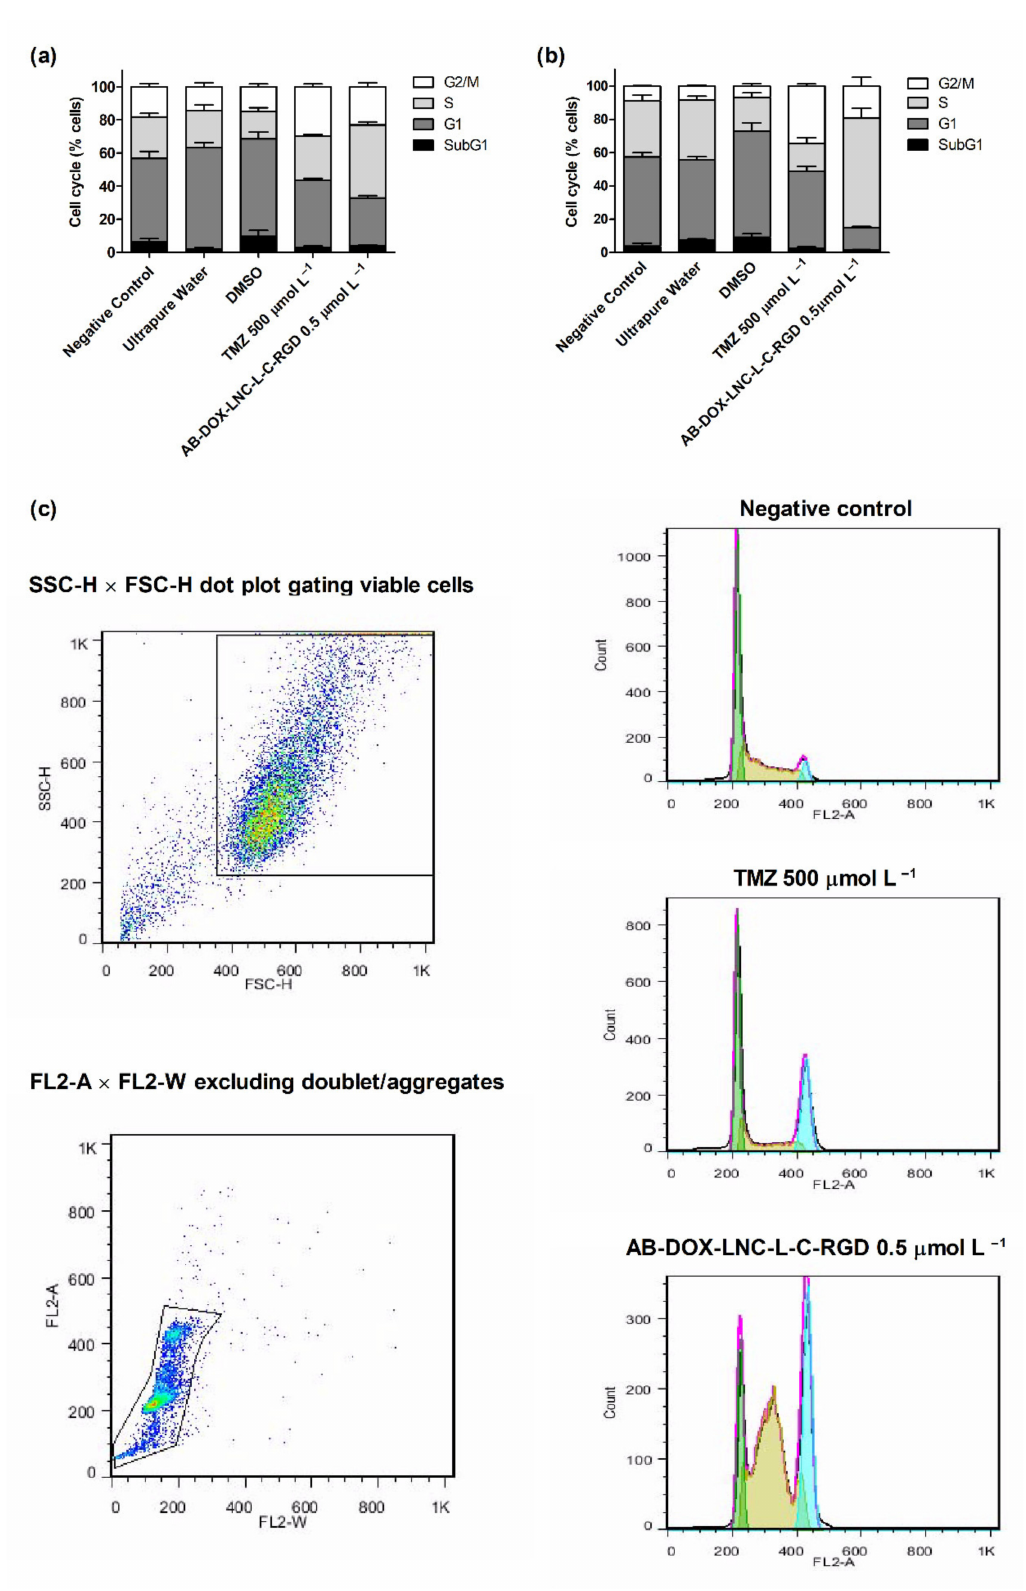
Figure 3. Cell cycle analysis using flow cytometry after 24 h of treatment for ( a ) U87MG cell line, ( b ) U138MG cell line, and ( c ) cell cycle representative histograms for U138MG cell line. Data are expressed as the mean ± SEM ( n = 3). Negative control (untreated cells-control 1), ultrapure water (control 2), DMSO (control